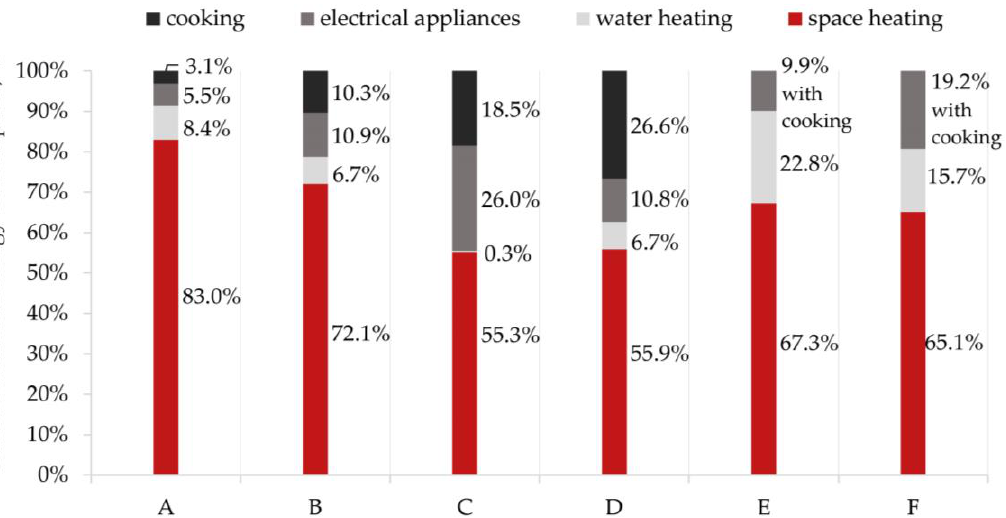
Figure 2. Structure of final energy consumption in the analyzed dwellings in the study period (from